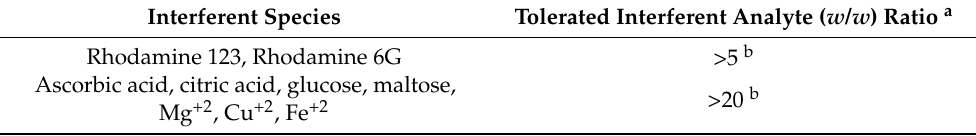
Table 2. Effect of the presence of potentially interfering compounds in the electrochemical response of Rhodamine B.